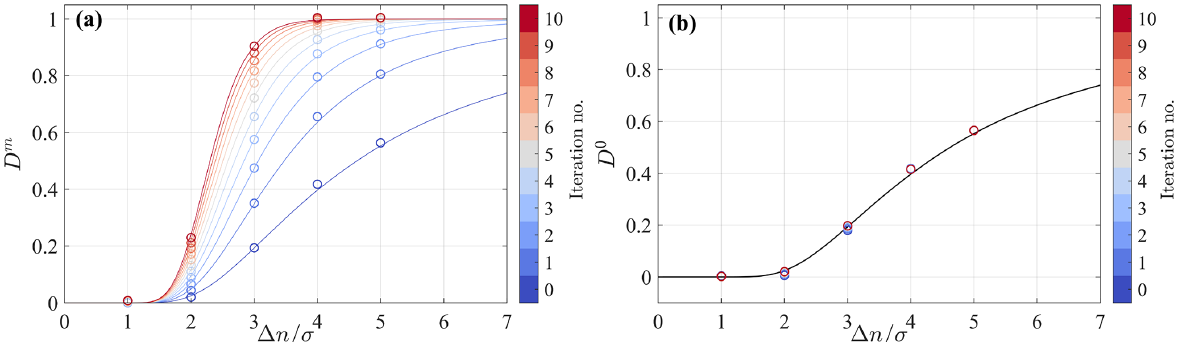
Figure 3. Validation of the 3D theoretical response of LiSBOA for the case N s = 20000 − L = 200. (a) Mean and (b) variance. The circles are the numerical output of the Monte Carlo simulation (Eq. 12), while the continuous lines represent Eq.